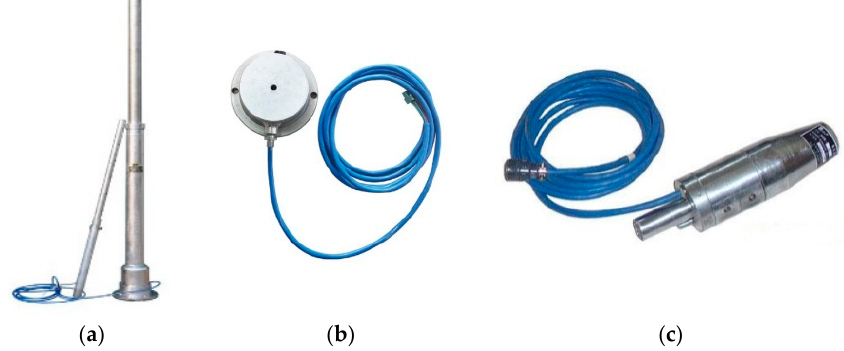
Figure 16. The monitoring layout of Panel 13080.